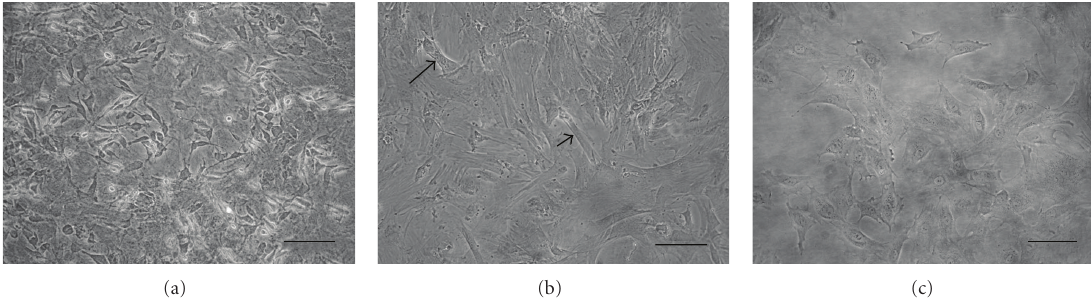
Figure 1: Cultures of undi ff erentiated rMSCs at di ff erent passages. At P1 rMSC cultures were morphologically heterogeneous (a). At P2 rMSC cultures consisted of a more homogeneous population of cells, most of which had a large flattened morphology (arrow). Relatively elongated cells were also present (arrow head) (b). At P50 rMSCs lost their morphology appearing more rounded (c). Bars:100 μ